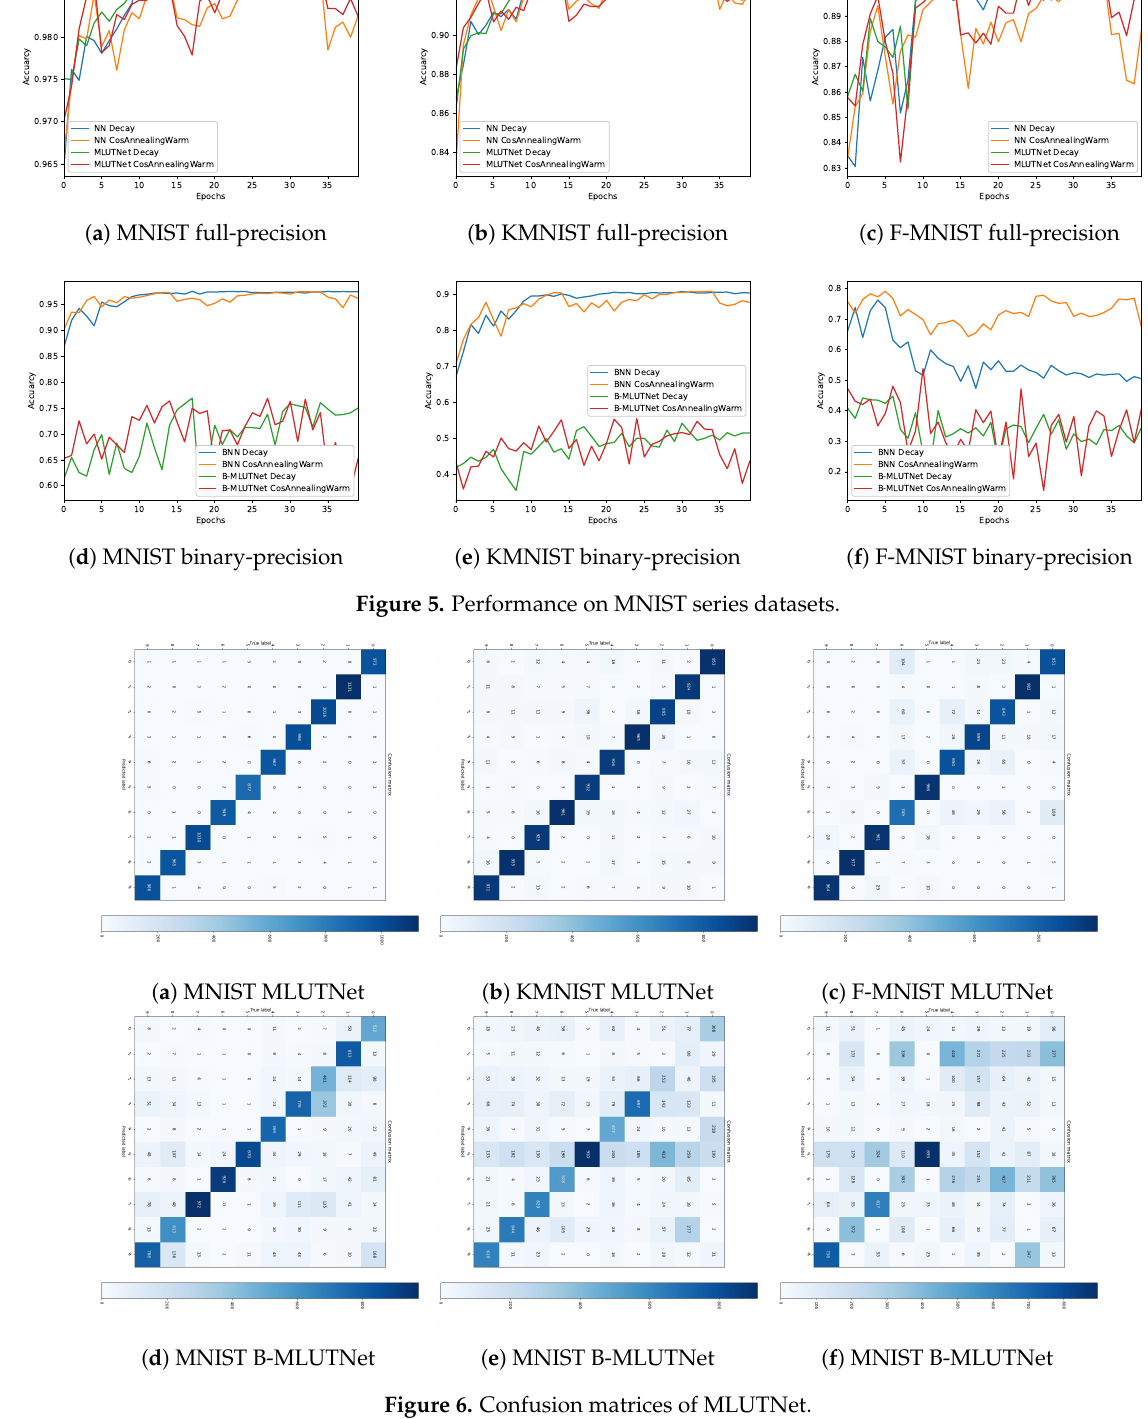
Figure 6. Confusion matrices of